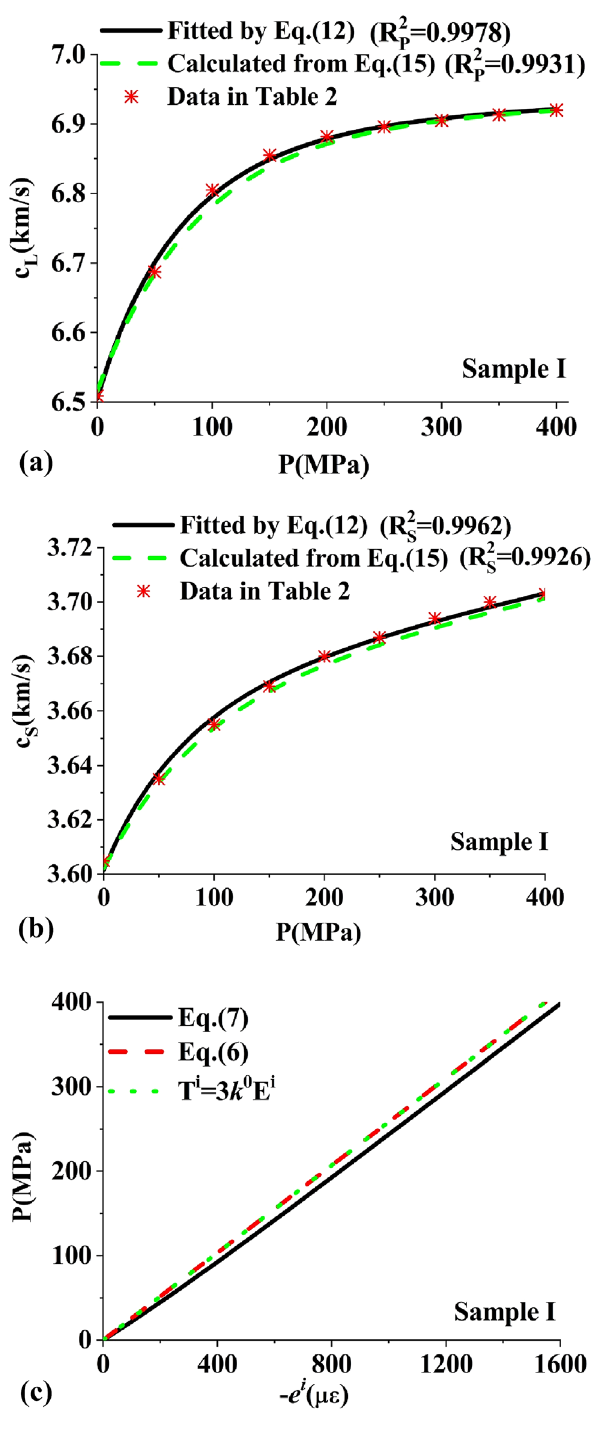
Fig. 1 Fitted results by Eq. (12), the calculated results by Eq. (15) and corresponding constitutive law for sample I, where P = − T i and e i = − 1 + √ 1 + 2 E i . a P-wave, b S-wave, and c constitutive laws